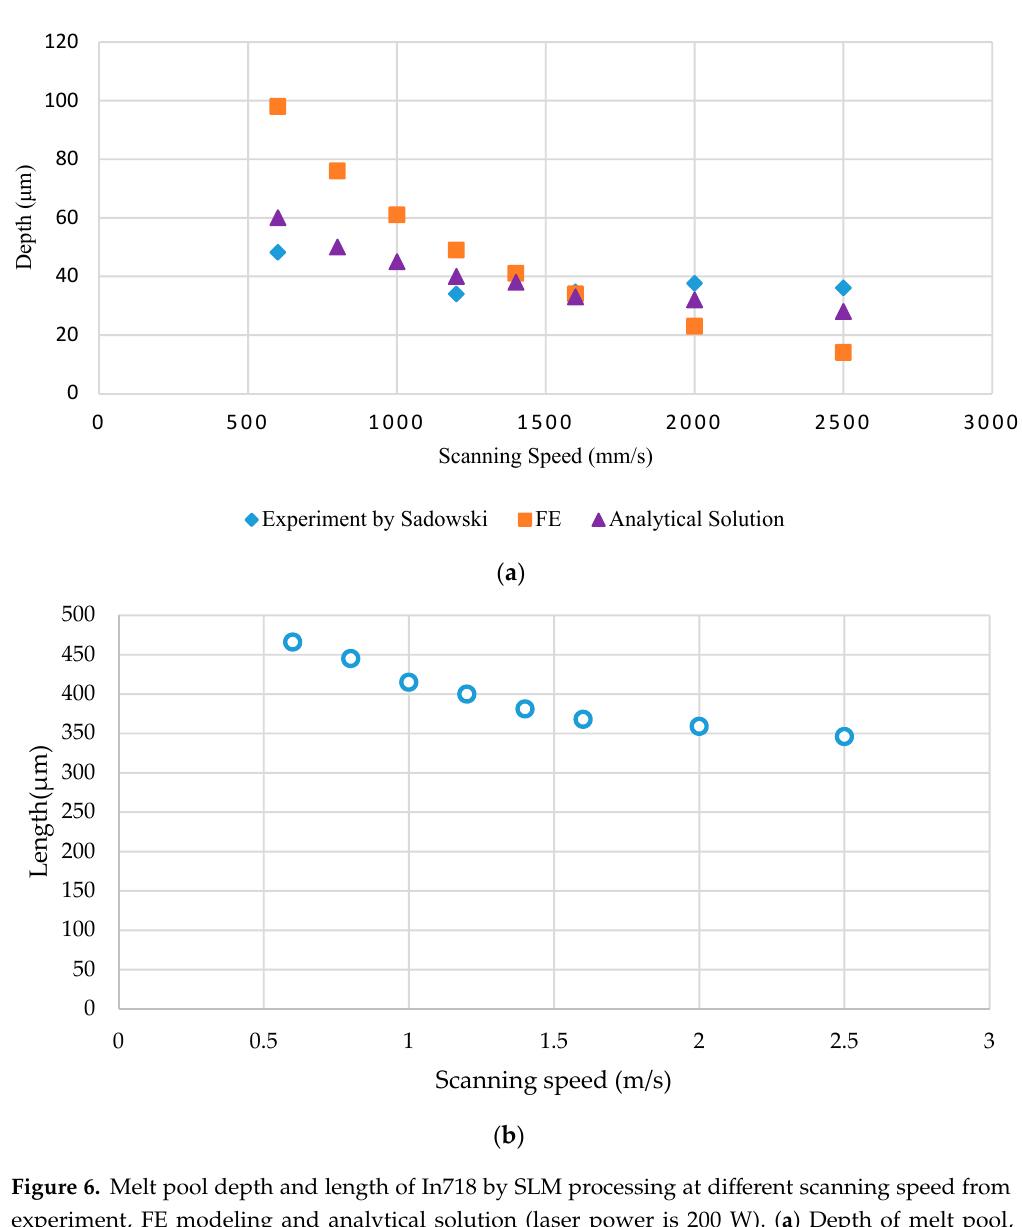
Figure 5. The dimension of melt pool of In718 by SLM processing at high heat input from experiment by Sadowski [12], FE modeling and analytical solution (equation from this paper and Rosenthal equation).